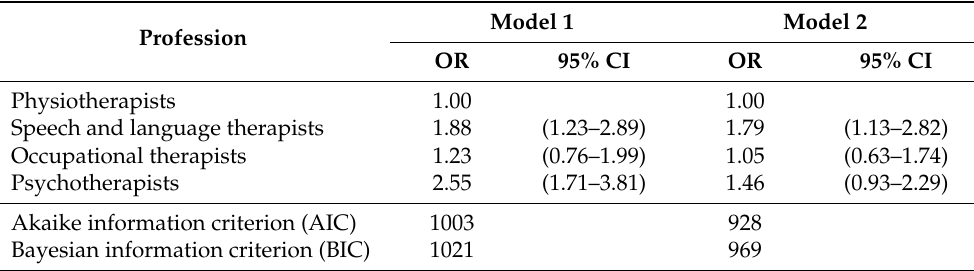
Table 4. Planning to use tele-rehabilitation also after COVID-19 pandemic probably/yes, regularly by profession among those who carried out tele-rehabilitation during the COVID-19 pandemic, odds ratios (OR) and 95% confidence intervals (CI) ( n =